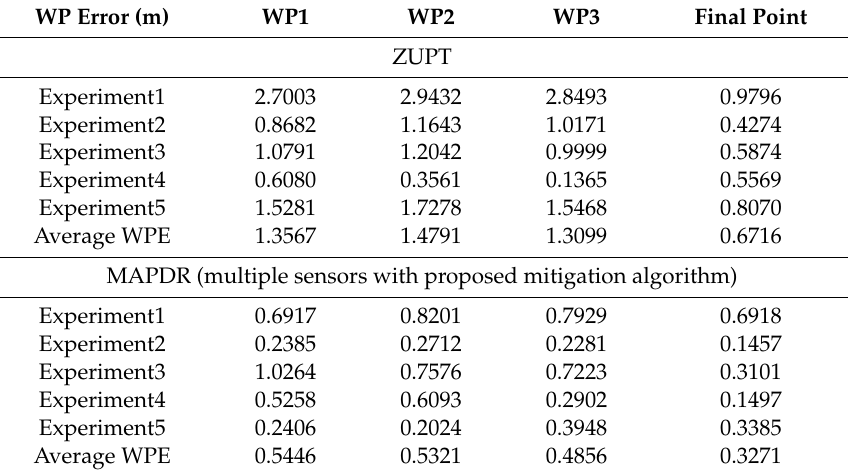
Table 7. Comparison of MAPDR and conventional PDR case of the partial map in experiment site